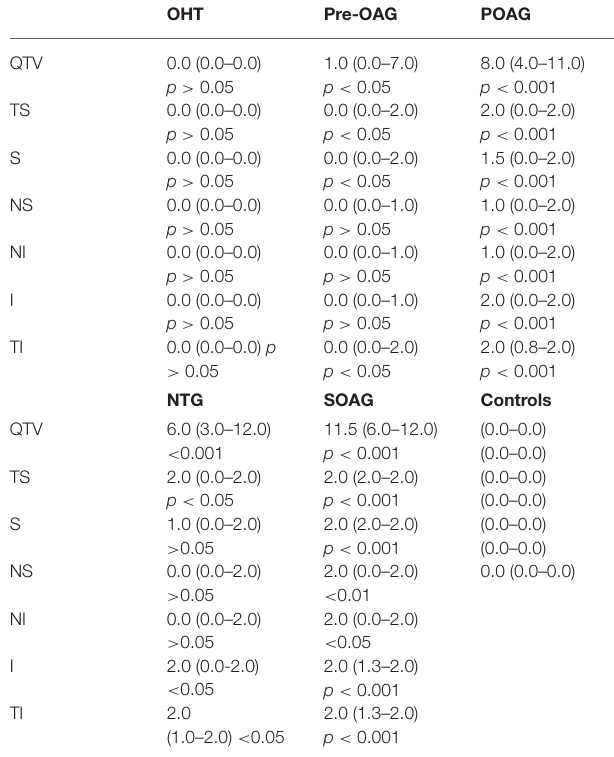
TABLE 5 | Total and sectorial RGCL thickness score (median, quartiles) of all subgroups (OHT, pre-OAG, NTG, POAG, SOAG, controls): QTV, qualitative total value; TS, temporal superior; S, superior; NS, nasal superior; NI, nasal inferior; I, inferior; TI, temporal inferior; p-values (p) for comparison of each subgroup with controls (Bonferroni-corrected).